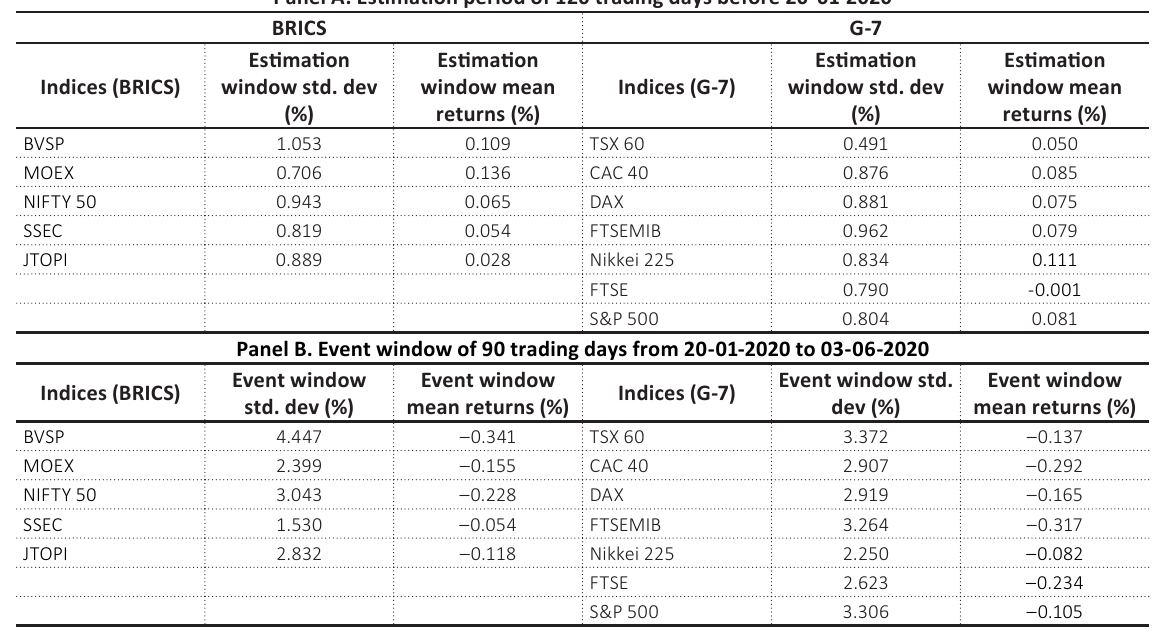
Table 2. Mean returns and standard deviation of G-7 and BRICS